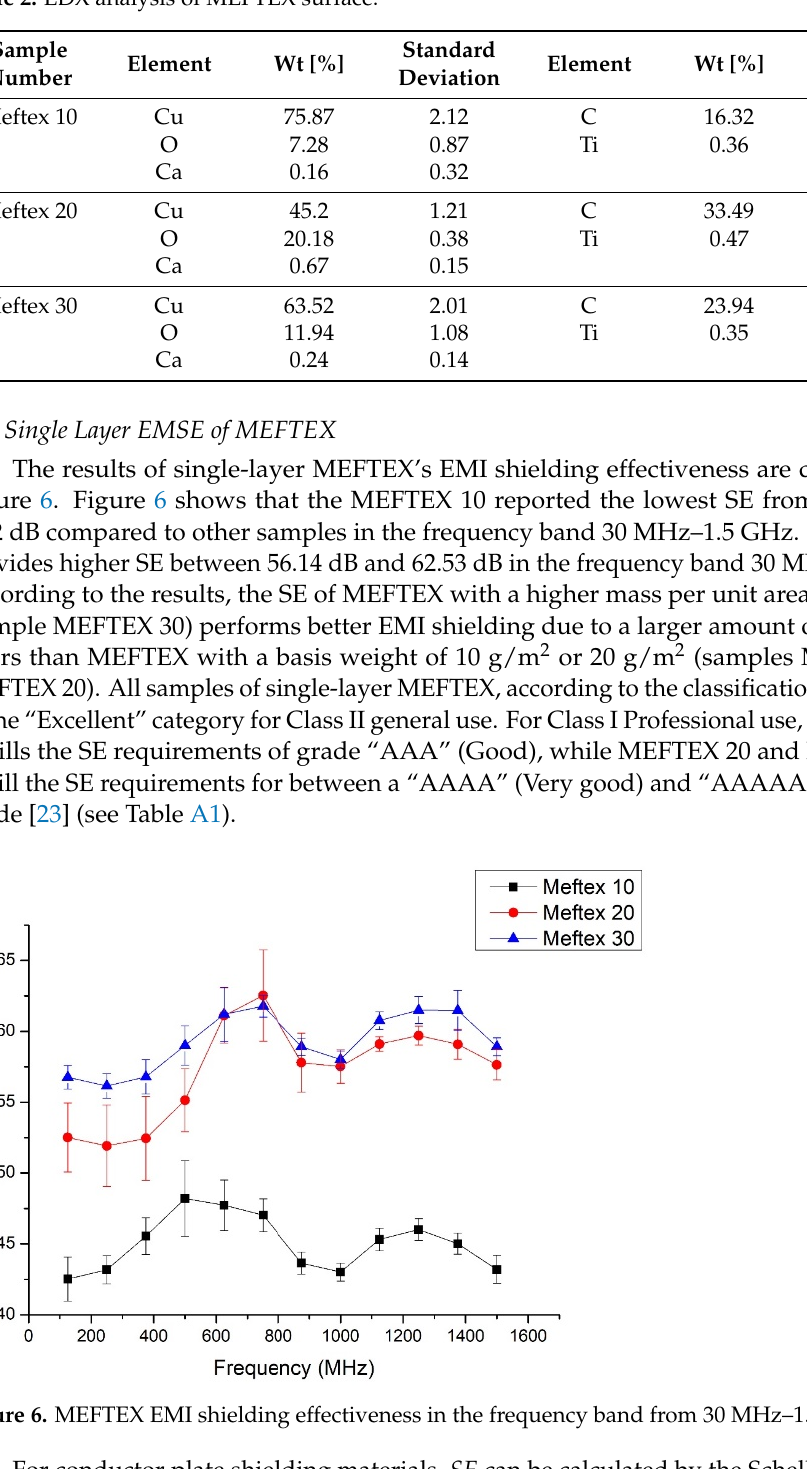
Table 2. EDX analysis of MEFTEX surface.